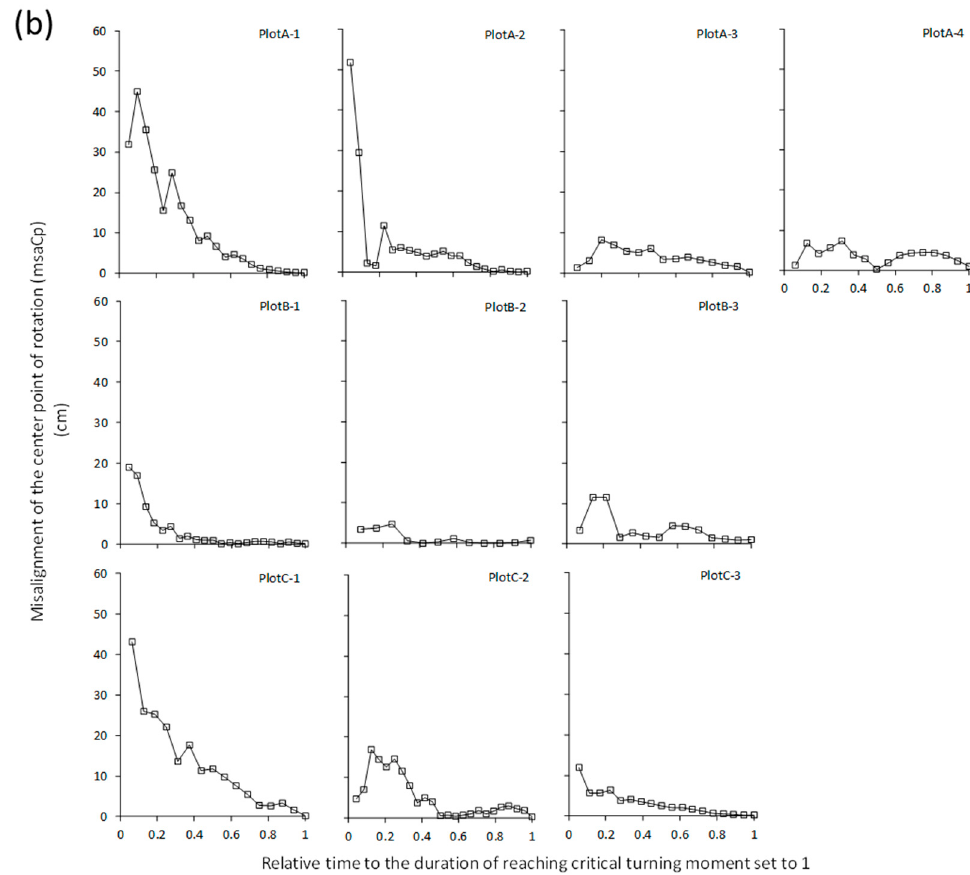
Figure 3. ( a ) Position of the center point of rotation (Cp) in 1 s intervals from the start of the tree- pulling experiment until the critical turning moment was reached in all 10 test trees. The arrows indicate the point at which the critical turning moment was reached. The time of reaching the critical turning moment is indicated in red. ( b ) Misalignment of Cp (msaCp) with relative time to the duration of reaching critical turning moment set to 1 in all 10 test trees.